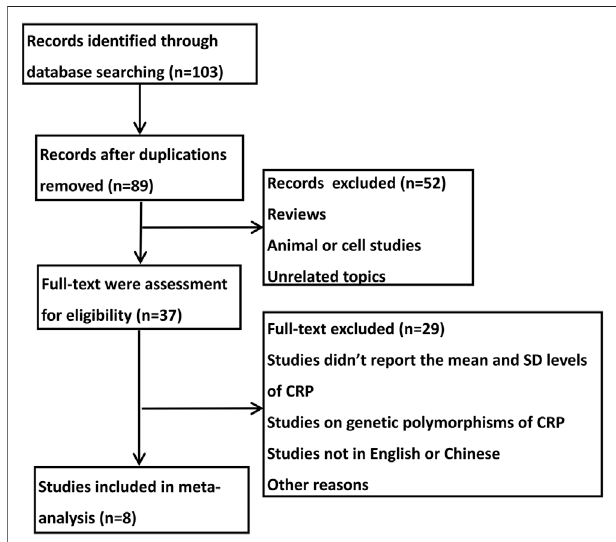
FIGURE 1 | Flowchart of studies selected for review and inclusion for